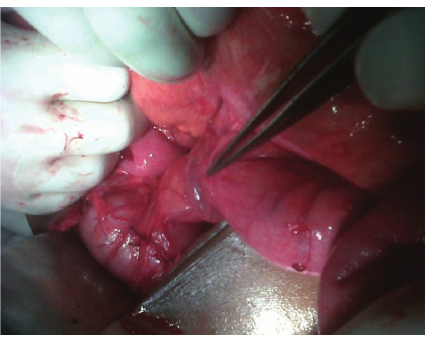
Figure 2: Inferior mesenteric vein situated on the right free margin of hernia